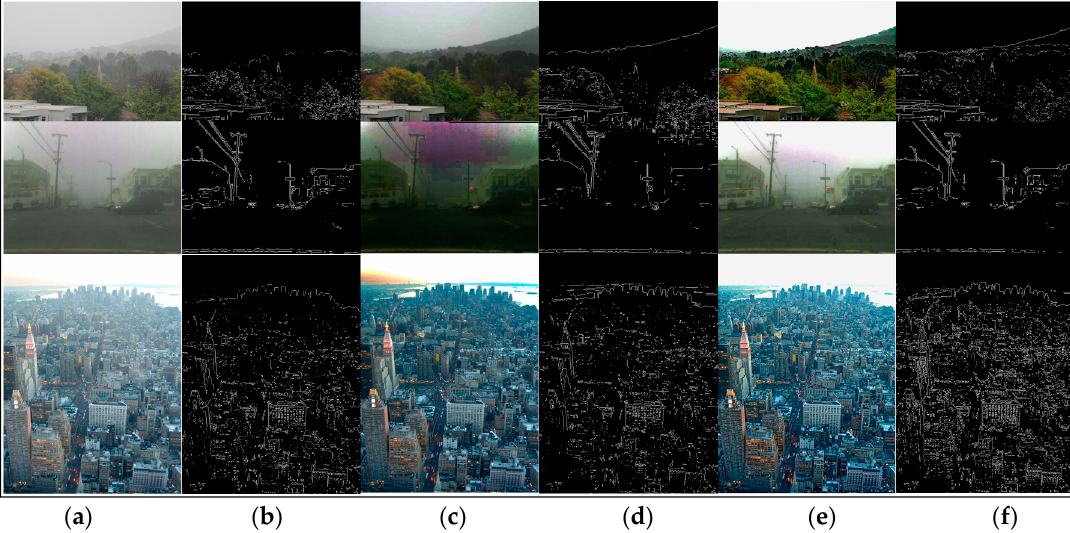
Figure 9. Comparison of our method to the He [16] soft matting based method using real-world images. ( a , b ) are input hazy images and their corresponding visible edges, respectively; ( c – f ) are the dehazing results with corresponding visible edges generated by the method of He [16] and ours, respectively.